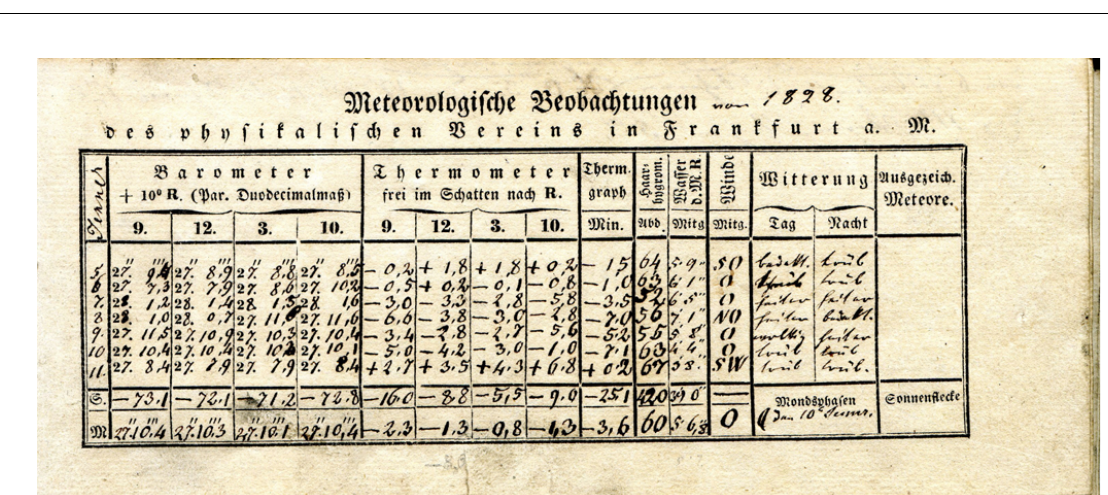
Figure 2. An example of handwritten historical documents with weather observations: Frankfurt, 1828 (5 to 11 January).